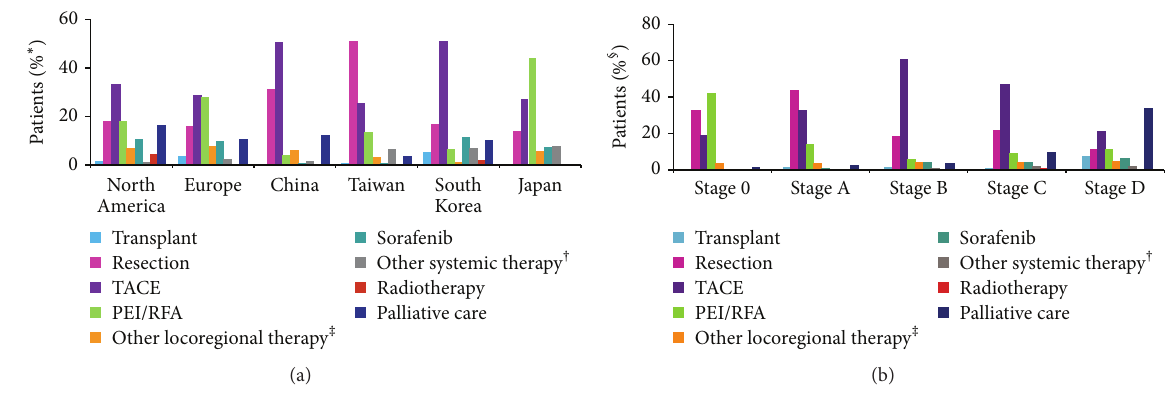
Figure 2: Treatment for HCC stratified based on region and stage. (From